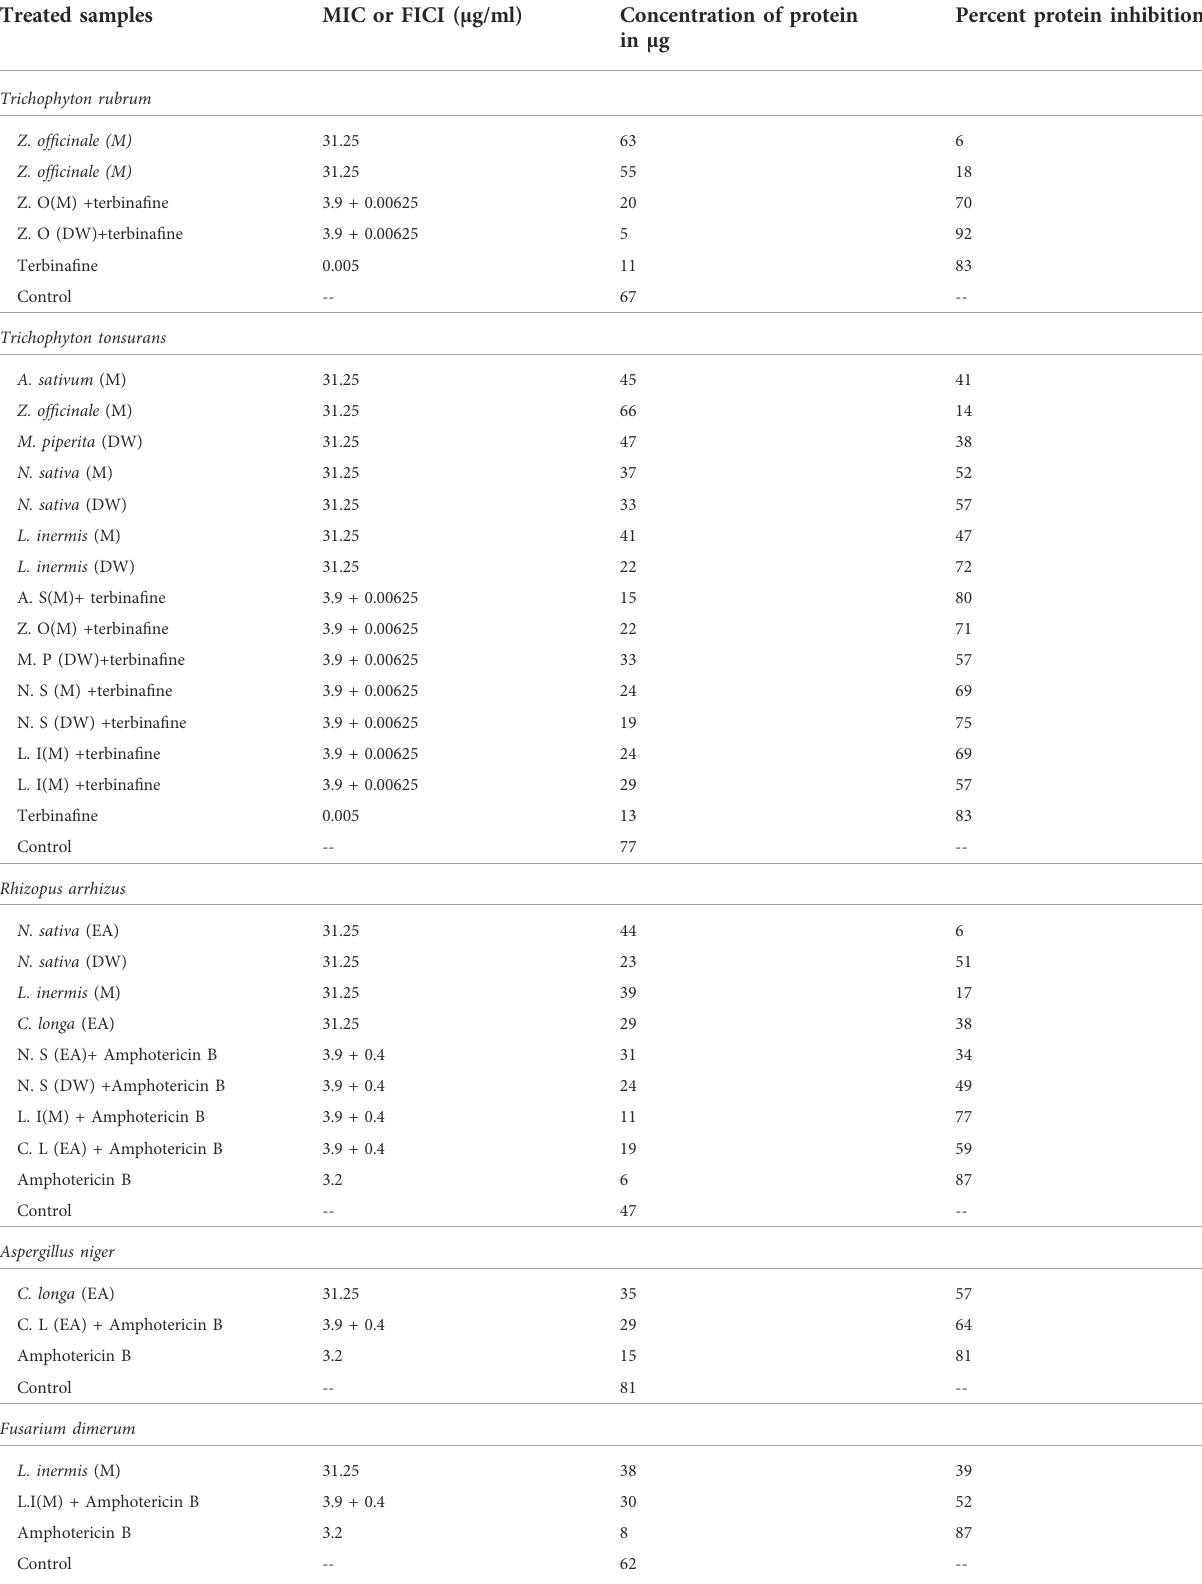
TABLE 7 Percent protein inhibition of extracts treated with dermatophytes and non-dermatophytes. Treated